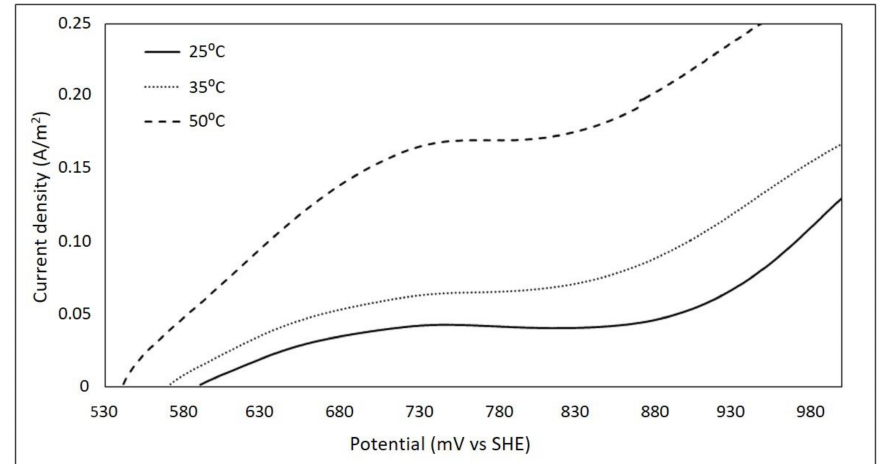
Figure 10. Effect of temperature at 25, 35, and 50 ◦ C on the chalcopyrite electrode (1 mV/s) using a solution with 20 g/L [Cl − ]; 0.5 g/L [Cu 2+ ], 1.0 g/L [Fe 2+ ], and pH 1 adjusted with sulphuric acid.